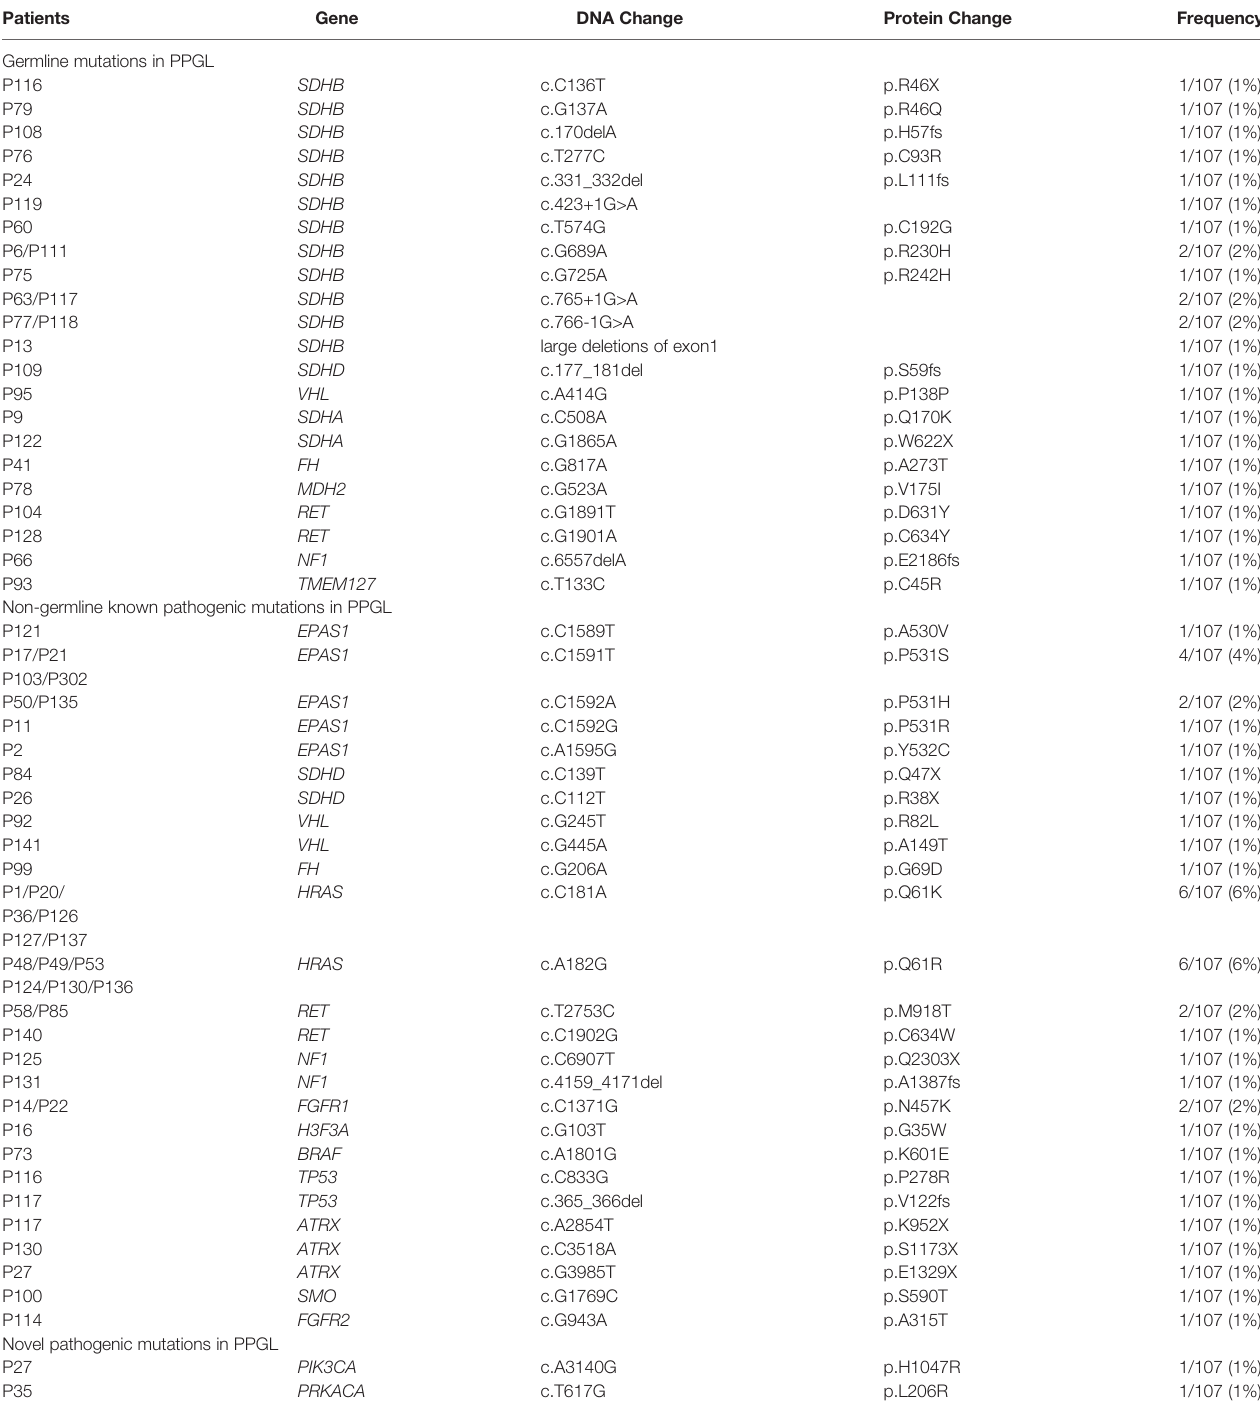
TABLE 2 | Pathogenic mutations in